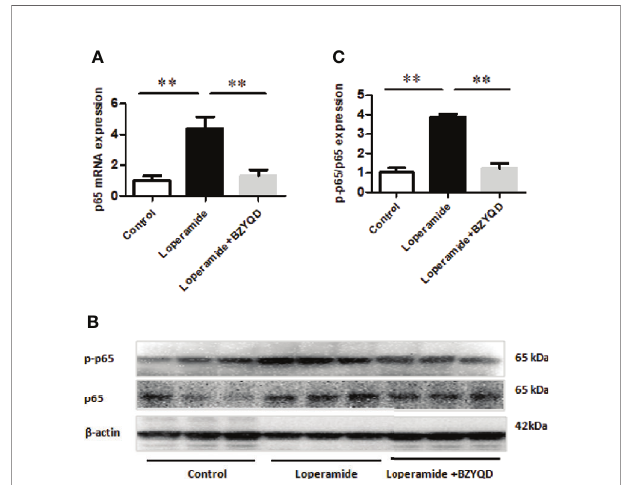
FIGURE 8 | Effect of BZYQD intervention on NF- k B signaling pathway in loperamide-treated rats. (A) The mRNA expression of p65 detected through real-time PCR. (B) The protein expression of p-p65 and p65 detected by western blot. (C) Ratio of protein expression of p-p65 and p65; data are represented as mean ± SD; n = 8 for real-time PCR and n = 3 for western blot. ** P < 0.01 between groups.